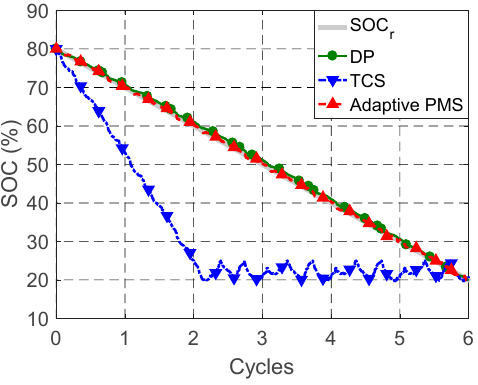
Energies 2019 , 12 , x FOR PEER REVIEW Figure 17. SOC responses for six FTP cycles. Figure 17. SOC responses for six FTP cycles.